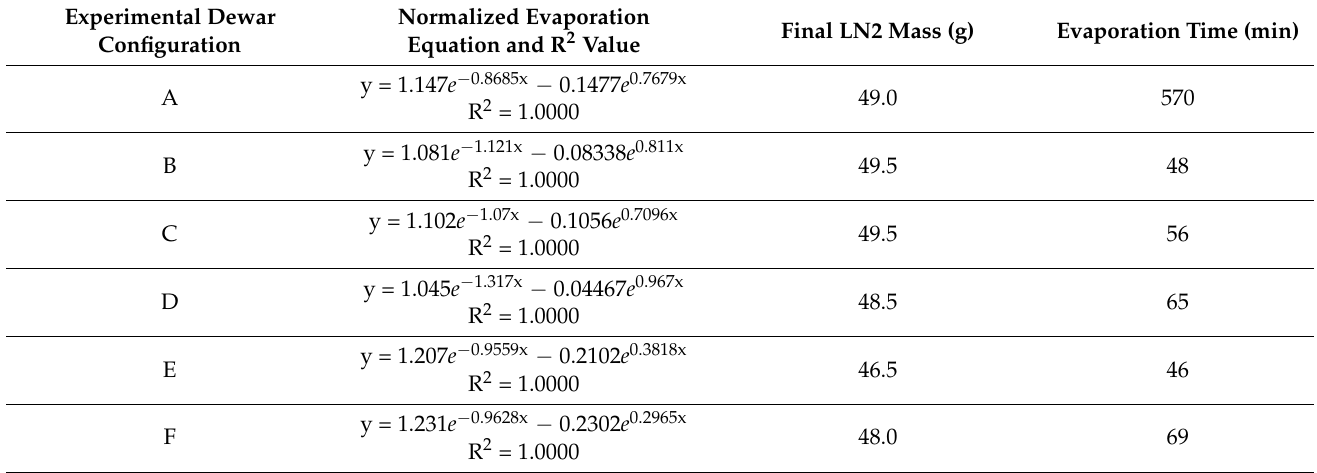
Table 2. Experimental Dewar LN2 normalized evaporation equations, R 2 values, final mass, and evaporation times. Initial LN2 mass for all configurations was 300 g with a start time of zero minutes. Evaporation equations are valid when both x and y values are positive. Experimental Dewar